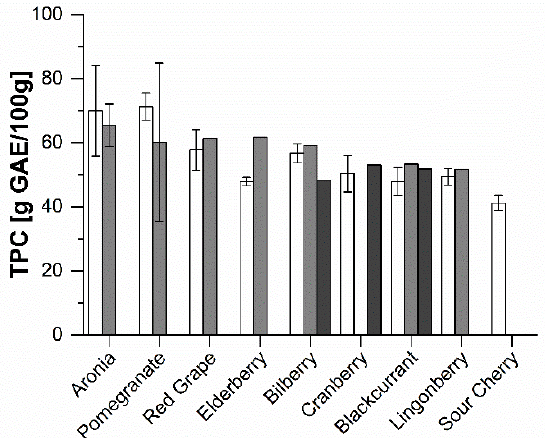
Figure 1. Total phenolic contents (TPC) of the extracts. Results are shown for extracts of direct juice (white), juice concentrate (light grey), and purees (dark grey), and are presented as means ± SD ( n = 3). GAE = gallic acid equivalent.